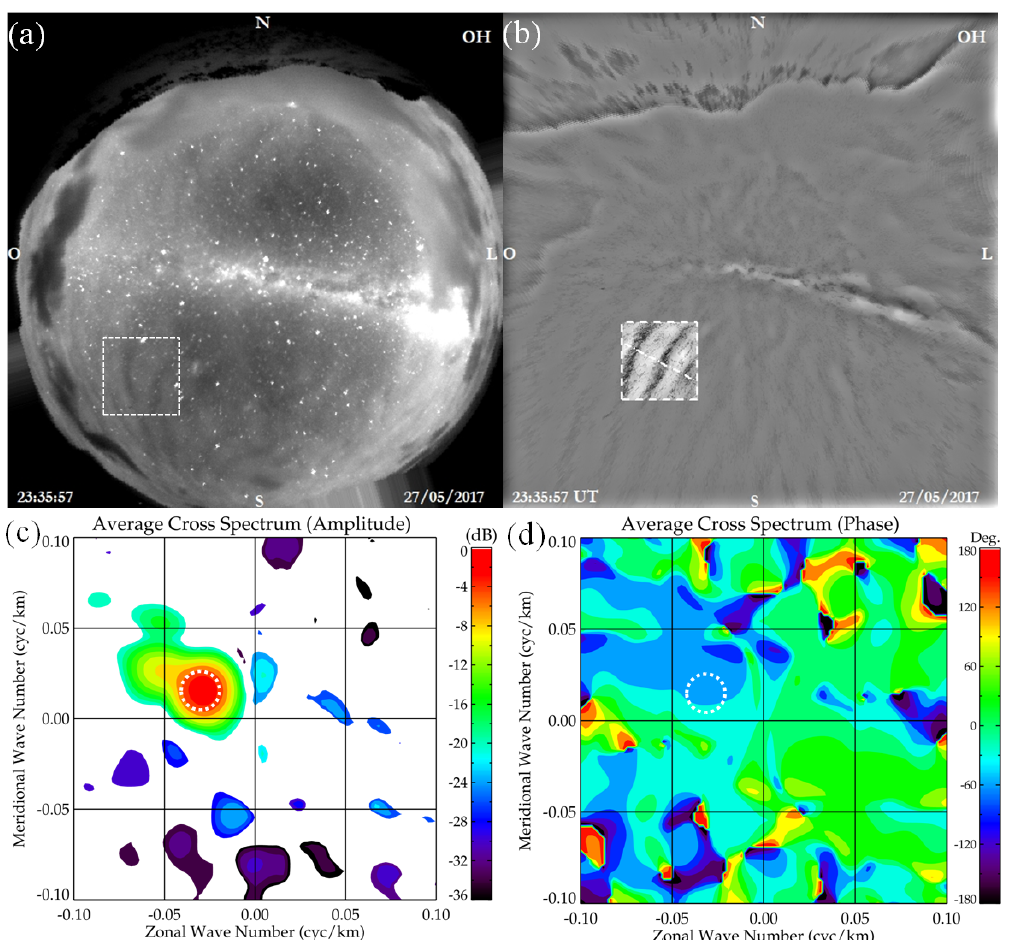
Figure 1. ( a ) Original image obtained by an all-sky imager observed at 23:35 UT on 27 May 2017. ( b ) Unwarped and high-pass filtered image. The white box shows the selected region used in spectral analysis. ( c ) Unambiguous averaged cross spectrum amplitude, obtained from the spectral analysis on the highlighted region and ( d ) the averaged phase of cross